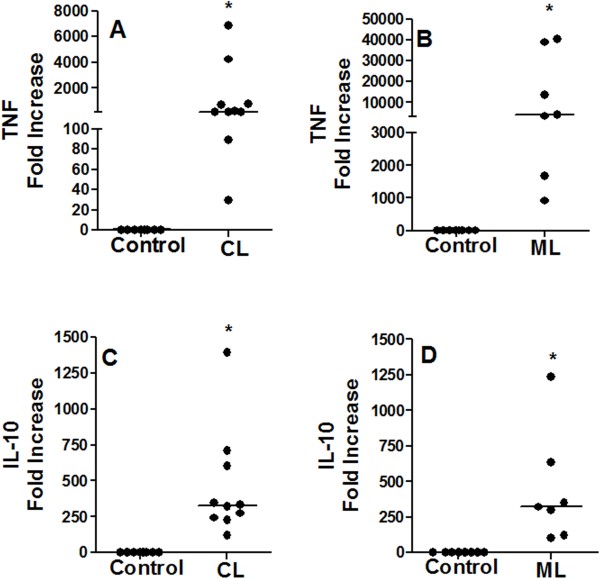
Increase of TNF mRNA and IL-10 mRNA in lesions of ATL patients: high levels of TNF mRNA in mucosal leishmaniasis. Total mRNA was extracted from fragments of healthy tissues (Control, skin n = 8; mucosa n = 8), cutaneous (CL, A and C, n = 10) or mucosal (ML, B and D, n = 7) lesions, and the expressions of TNF mRNA (A, B) and IL-10 (C, D) were analysed by qPCR. Results are showed as individual and median value. *p < 0.05.